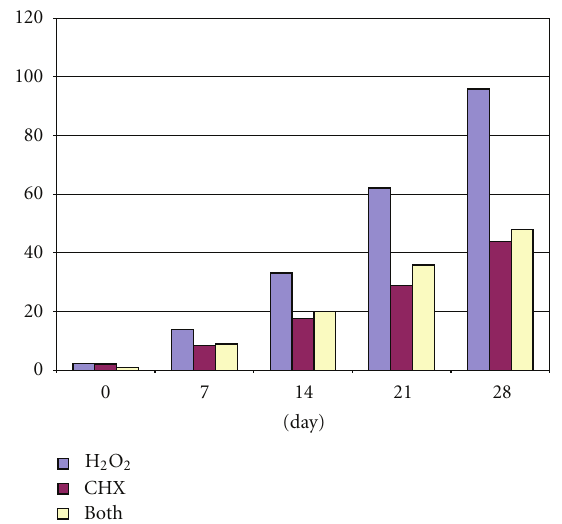
Figure 2: The number of CFU in three experimental groups at five